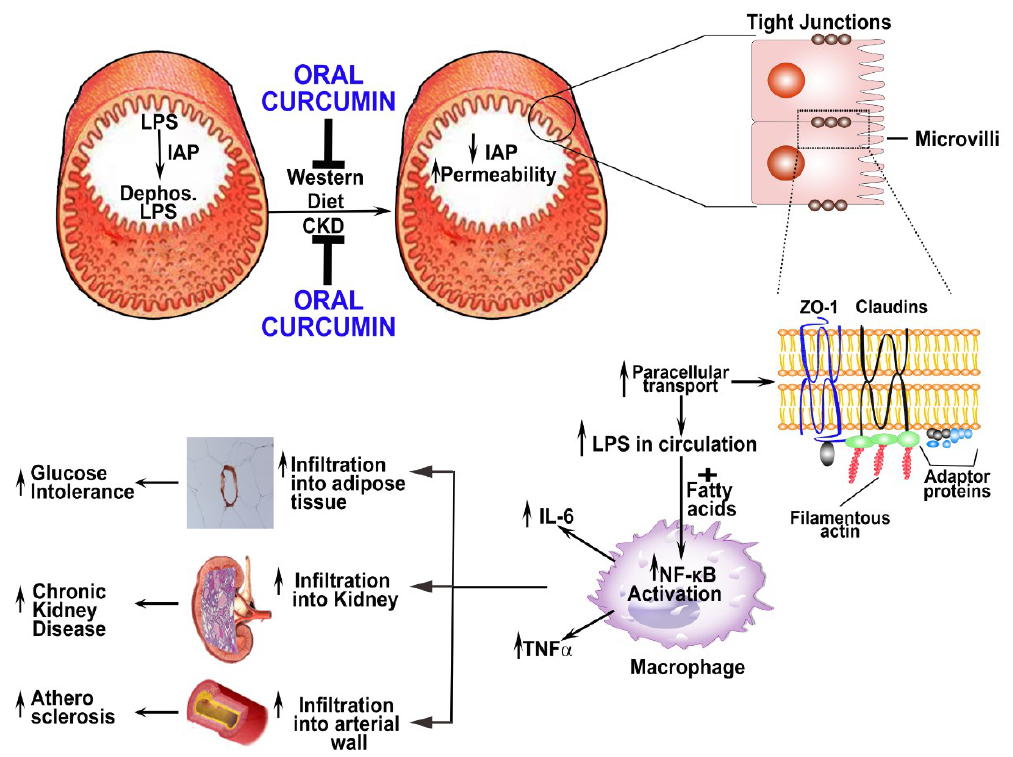
Figure 2. Proposed model for the role of intestinal barrier dysfunction in development of CKD, glucose intolerance and atherosclerosis and its modulation by curcumin. Intact intestinal barrier restricts the release of bacteria as well as bacterial products such as LPS into circulation. Consumption of Western diet as well as CKD affects this barrier function likely at multiple levels including decrease in Intestinal Alkaline Phosphatase (IAP) and/or increase in epithelial permeability resulting from a decrease in epithelial tight junction proteins (ZO-1, Claudins). IAP, an enzyme present in the lumen, detoxifies luminal LPS by catalyzing the removal of one of the two phosphate groups from the toxic lipid A moiety of LPS. Western diet-induced reduction in IAP activity, therefore, is likely to increase the levels of active LPS within the intestinal lumen. Luminal LPS-induced decrease in the expression of tight junction proteins ZO-1 and Claudin increases the paracellular transport of LPS into circulation; increased levels of circulating LPS are associated with CKD as well as Western-diet induced diseases such as atherosclerosis and Type 2 diabetes. Plasma LPS along with Western diet-induced increase in circulating fatty acids promotes macrophage activation and induce NF-κB-driven gene expression resulting in increased secretion of pro-inflammatory cytokines and chemokines. Activated macrophages also infiltrate into adipose tissue, kidney and/ or artery wall leading to the development of glucose intolerance, CKD and atherosclerosis, respectively. Oral administration of curcumin increases IAP activity as well as reverses the LPS-mediated decrease in tight junction proteins. Preservation of the intestinal barrier function at multiple levels (e.g., IAP, tight junction proteins) thus represents a novel mechanism by which poorly absorbed curcumin exerts potent anti-inflammatory effects leading to attenuation of CKD and/or Western diet-induced glucose intolerance and